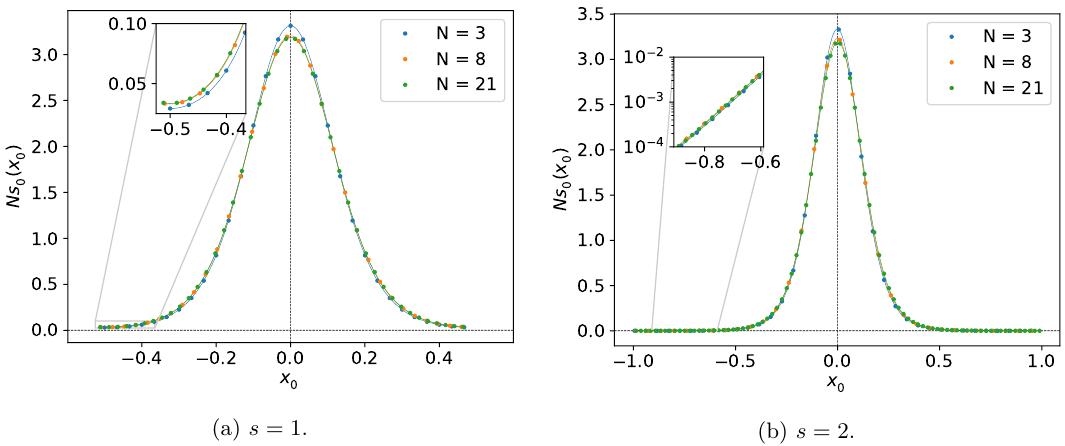
Figure 6. We compare the time dependence of the energy for various gauge groups N and time extents l = sl , with s = 1 and 2. The inset in the right plot is in logarithmic ( y − ) scale to show 0 that the decay in the tails is exponential in time.